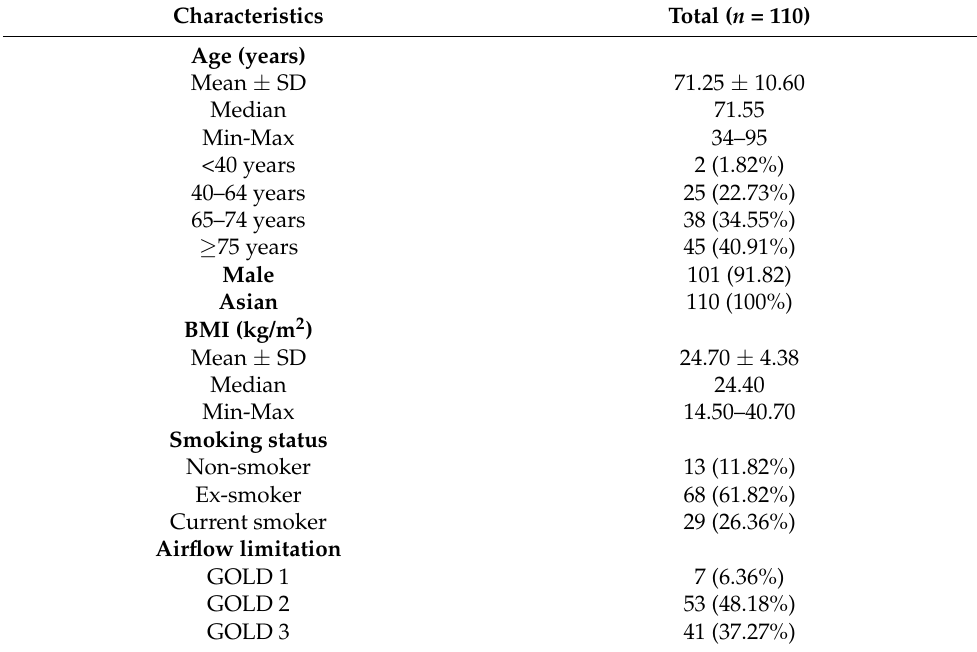
Table 1. Baseline information of the enrolled